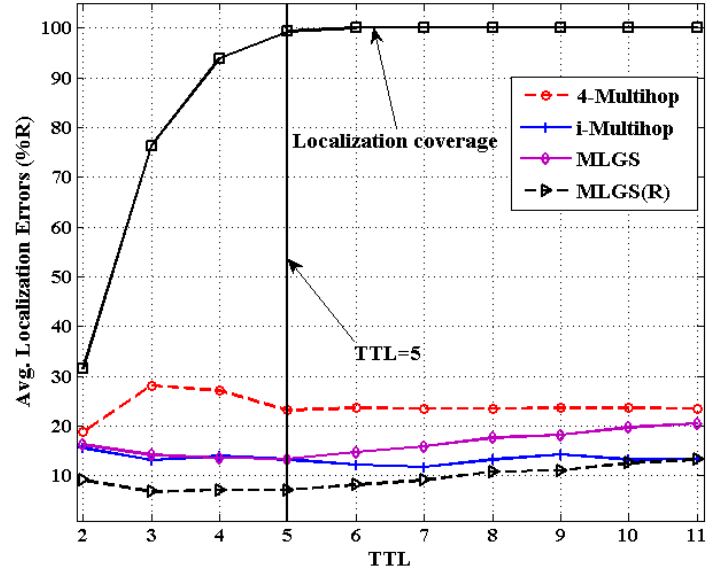
Figure 12. Average localization error versus TTL (isotropic network).